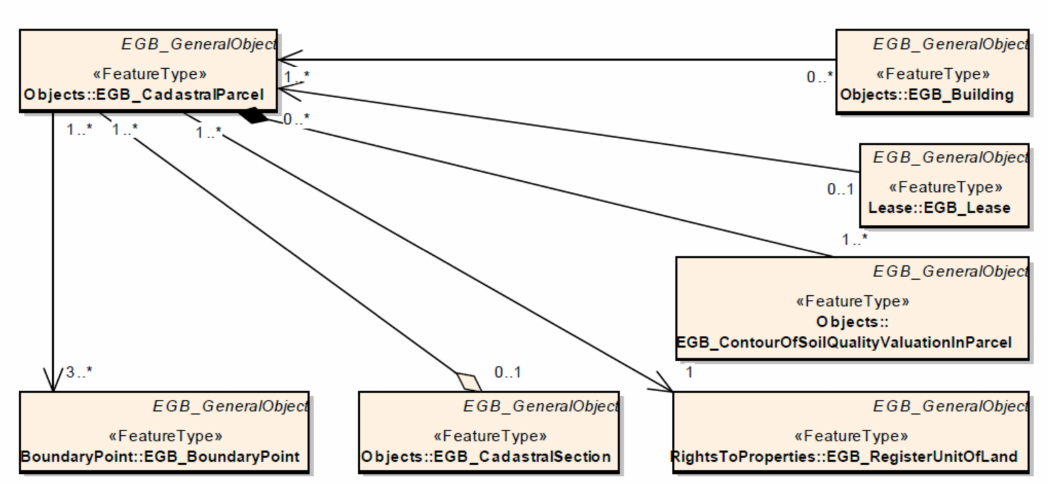
Figure 2. The relationships between ‘EGB_CadastralParcel’ and other classes of the Polish cadastral model. A building is a structure as defined by the Regulation of the Council of Ministers of 30 December 1999